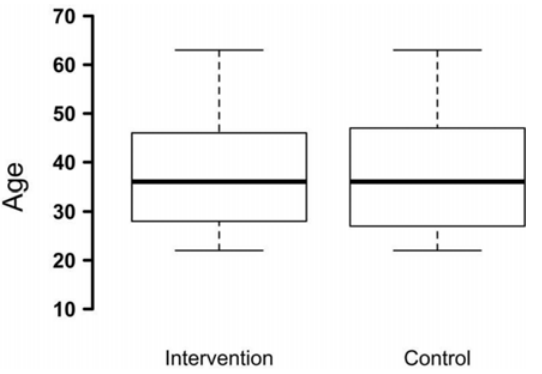
Fig 3. Comparison of age between the intervention and control arm. The central middle line is the median age. The boxes contain 50% of the data, the arms 25 and 25% of the remaining data. No outliers were found.